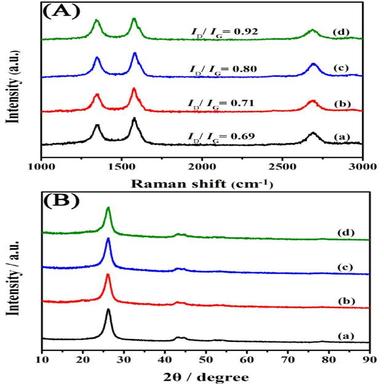
(A) Raman spectra and (B) XRD patterns of (a) CNTs, (b) CNTs-DPHE-1, (c) CNTs-DPHE-2 and (d) CNTs-DPHE-3.